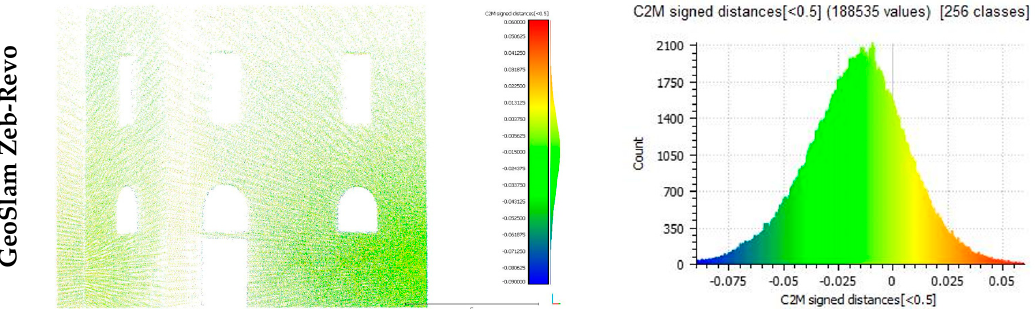
Figure 23. Comparison between the datasets under examination and a meshed reference. On the right are the histograms of the signed distances. C2M: cloud to mesh.